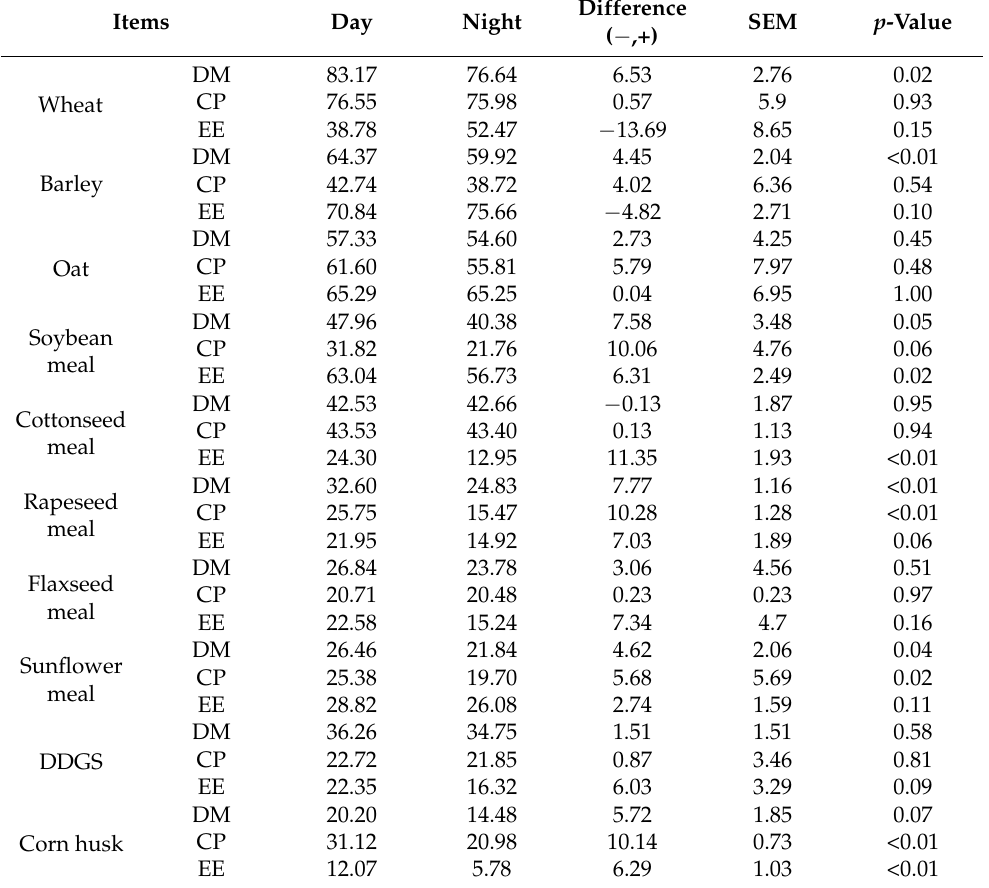
Table 7. Rumen digestibility of concentrate nutrients during daytime and nighttime (%, dry